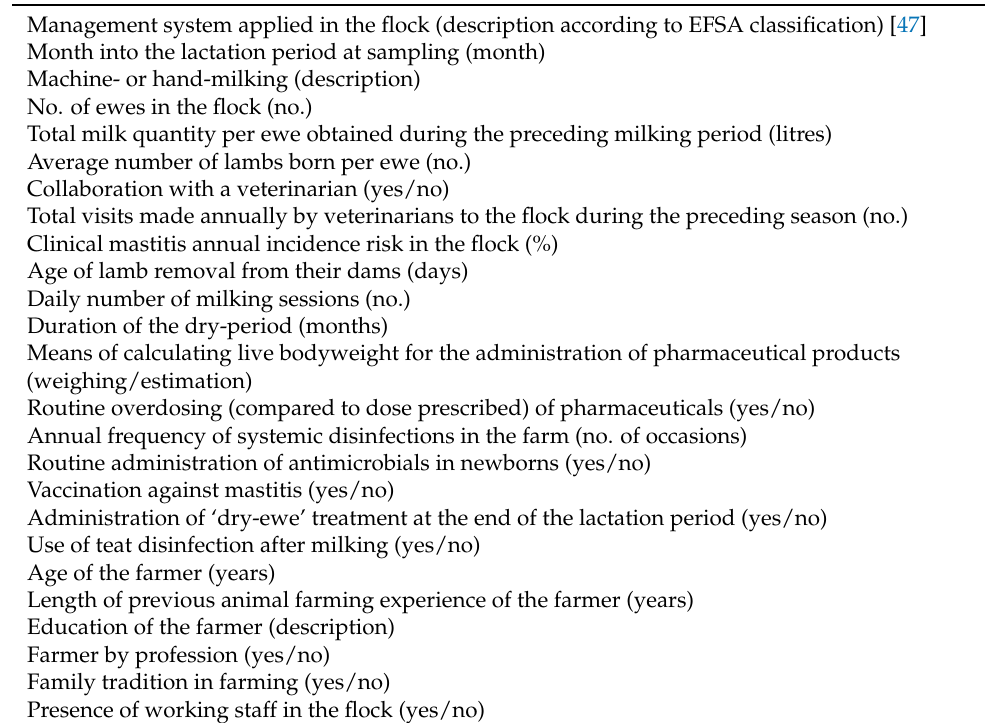
Table A1. Variables ( n = 25) evaluated for potential association with presence of antibiotic resistance in staphylococci isolated from the bulk-tank milk of 325 sheep flocks in Greece. Management system applied in the flock (description according to EFSA classification) [47] Month into the lactation period at sampling (month) Machine- or hand-milking (description) No. of ewes in the flock (no.) Total milk quantity per ewe obtained during the preceding milking period (litres) Average number of lambs born per ewe (no.) Collaboration with a veterinarian (yes/no) Total visits made annually by veterinarians to the flock during the preceding season (no.) Clinical mastitis annual incidence risk in the flock (%) Age of lamb removal from their dams (days) Daily number of milking sessions (no.) Duration of the dry-period (months) Means of calculating live bodyweight for the administration of pharmaceutical products